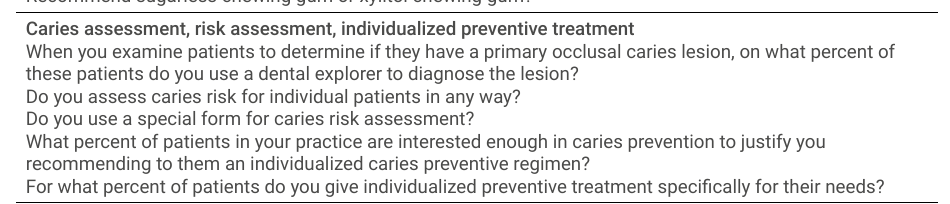
Recommend sugarless chewing gum or xylitol chewing